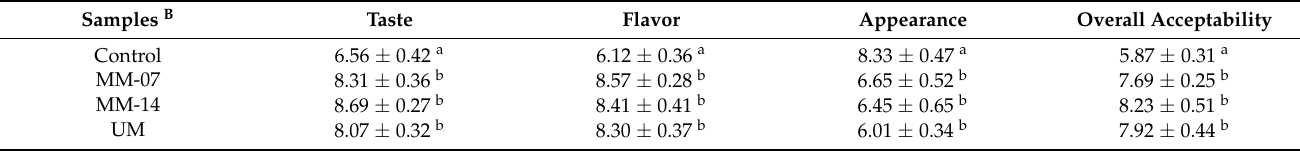
Table 6. The sensory evaluation of SFO samples A